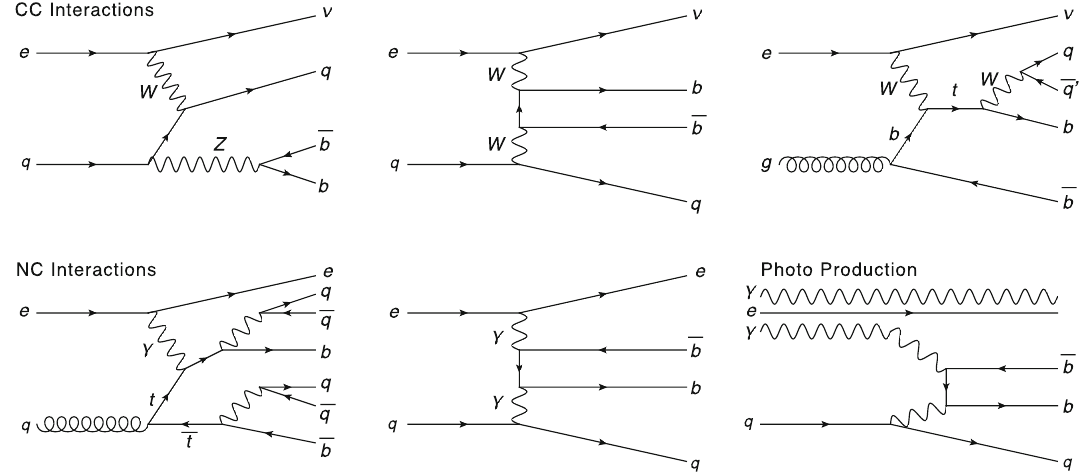
Fig. 2 Example Feynman diagrams for background processes. Upper row: charged current interactions, Lower row: neutral current interactions and